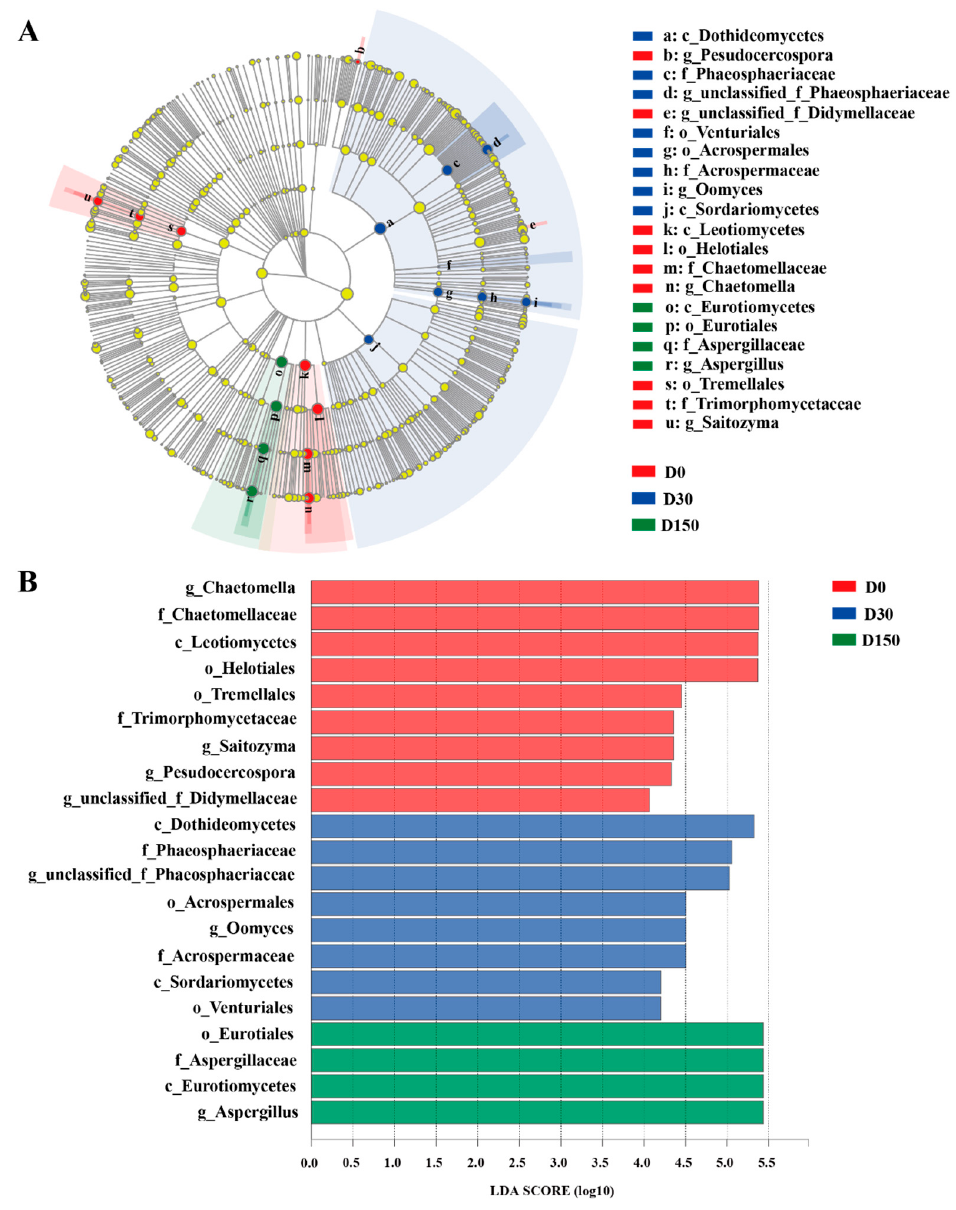
Figure 4. The cladogram ( A ) and histogram ( B ) show fungal taxa with a linear discriminant analysis (LDA) score > 4.0 using linear discrimination analysis coupled with effect size analysis.